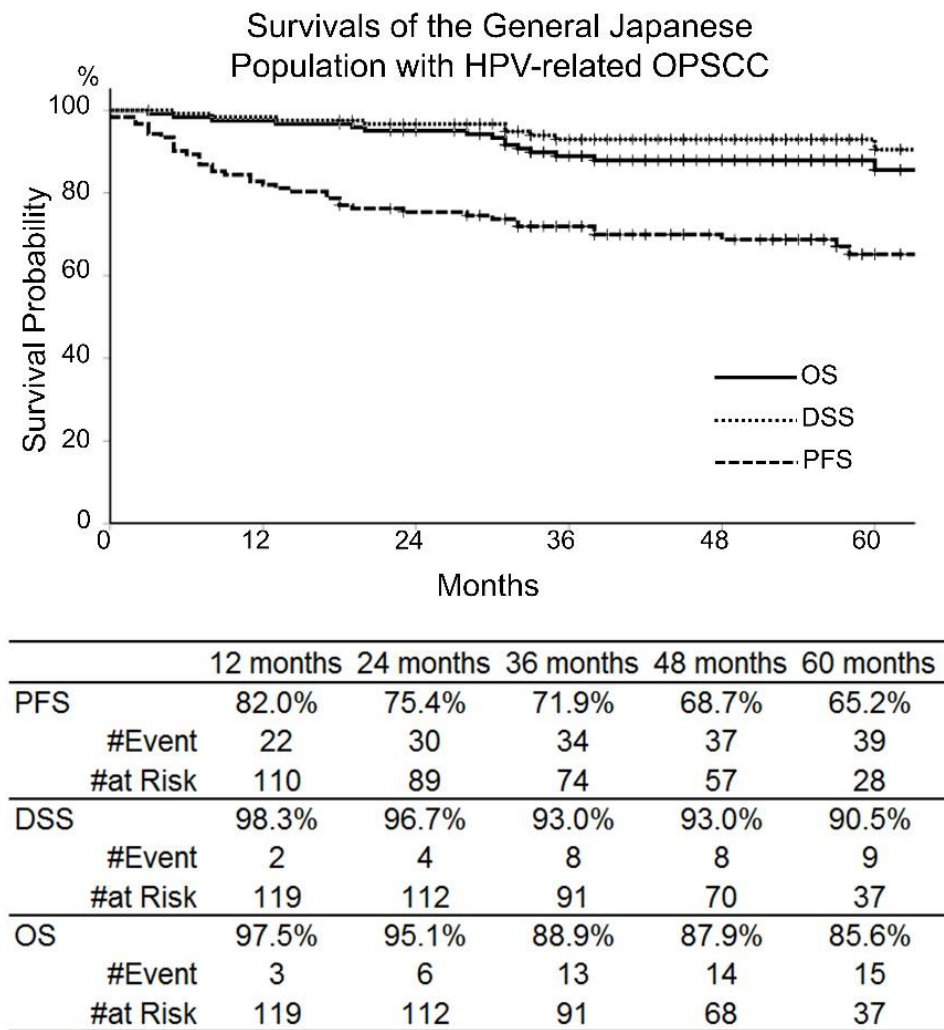
Figure 1. Progression-free survival (PFS), disease-specific survival (DSS), and overall survival (OS) of the 122 patients with human papillomavirus-related oropharyngeal squamous cell carcinoma (HPV-related OPSCC) in the clinical stages III and IV, according to the TNM 7th edition, who were treated between 2010 and 2018.